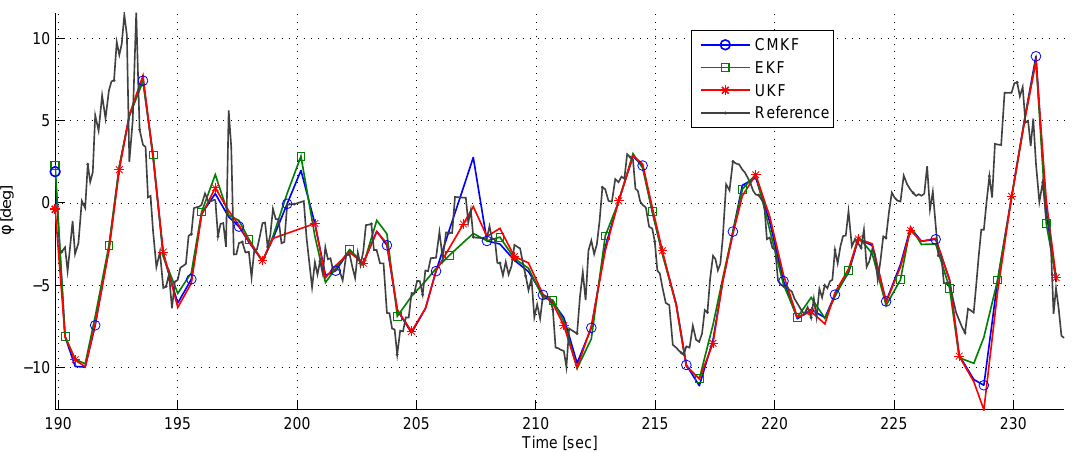
Figure 21. A comparison of the azimuth estimates using different filters in the dynamic